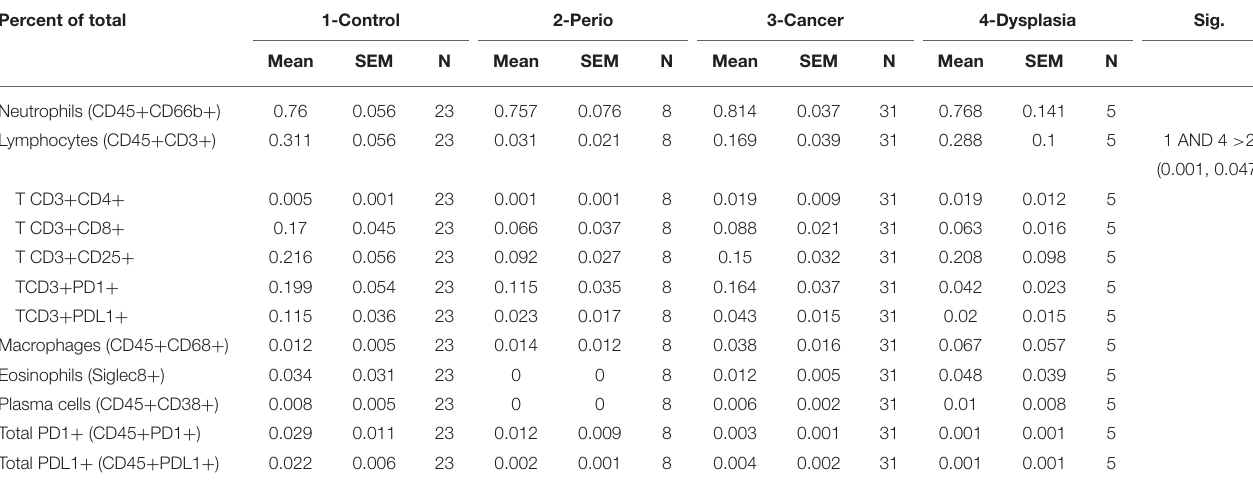
TABLE 5 | Distribution of salivary immune cells (percentage of all identified cells). Percent of